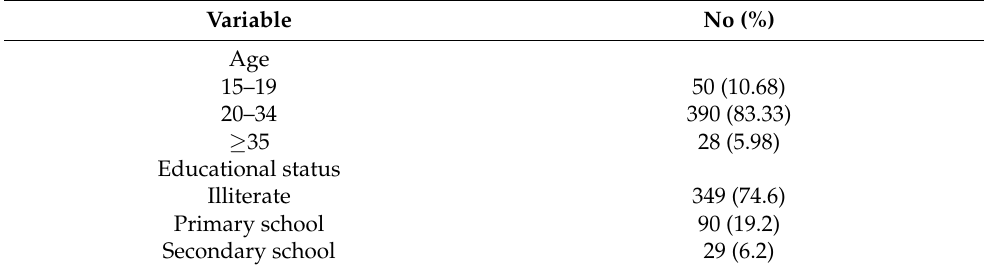
Table 1. Demographic Characteristics of Participants (N =